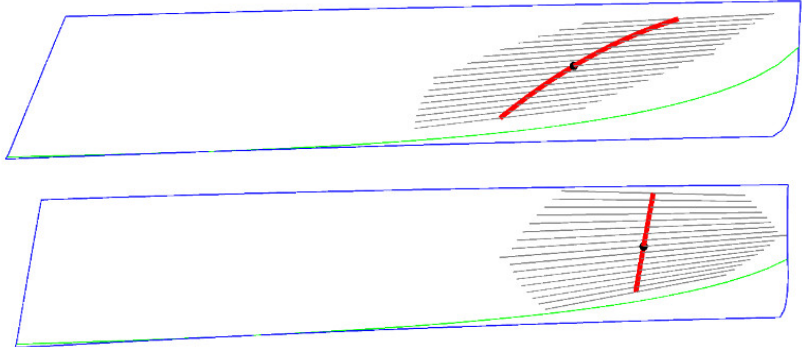
Figure 14. Contact diagrams of the helical face gears with different pressure angles (above: α n = 22.5°; below: α n = 20°).